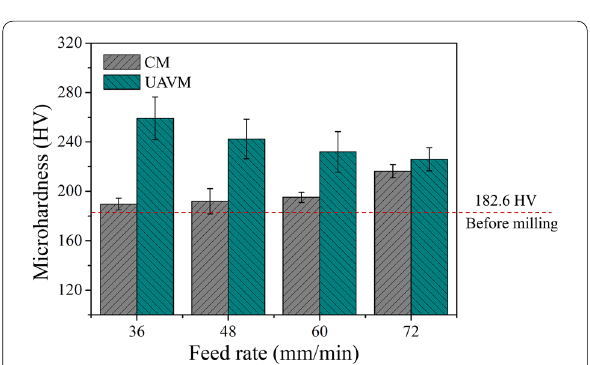
Figure 9 Microhardness of the workpiece surfaces machined under various